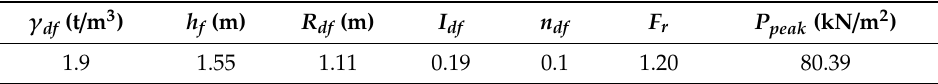
Table 5. Calculation results of the debris flow impact force on the retaining wall on 21 June